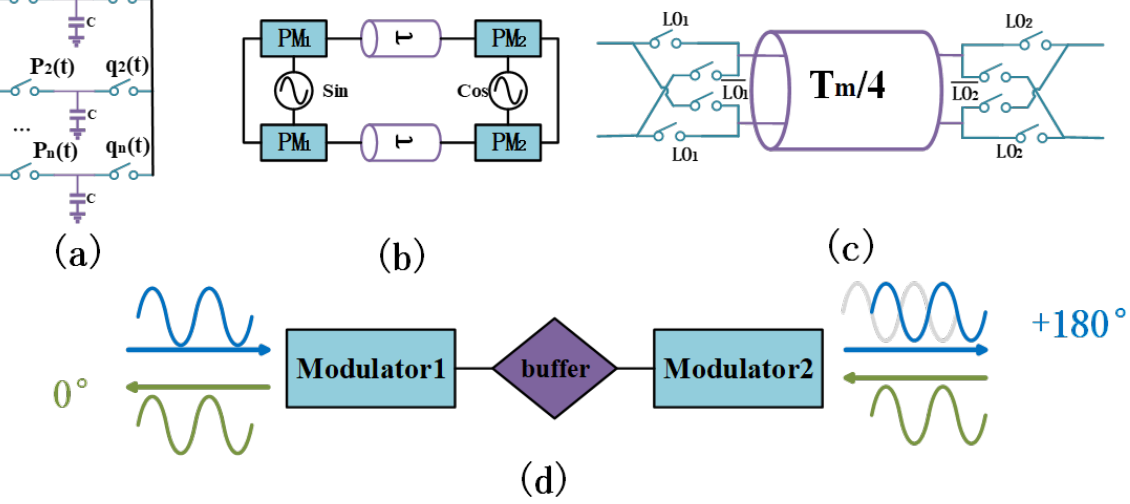
Figure 1. Different types of gyrators or isolators and summary topology. ( a ) N-path filter. ( b ) Optical isolator based on tandem modulators. ( c ) Conductivity modulation. ( d ) The general structure of nonreciprocal devices.